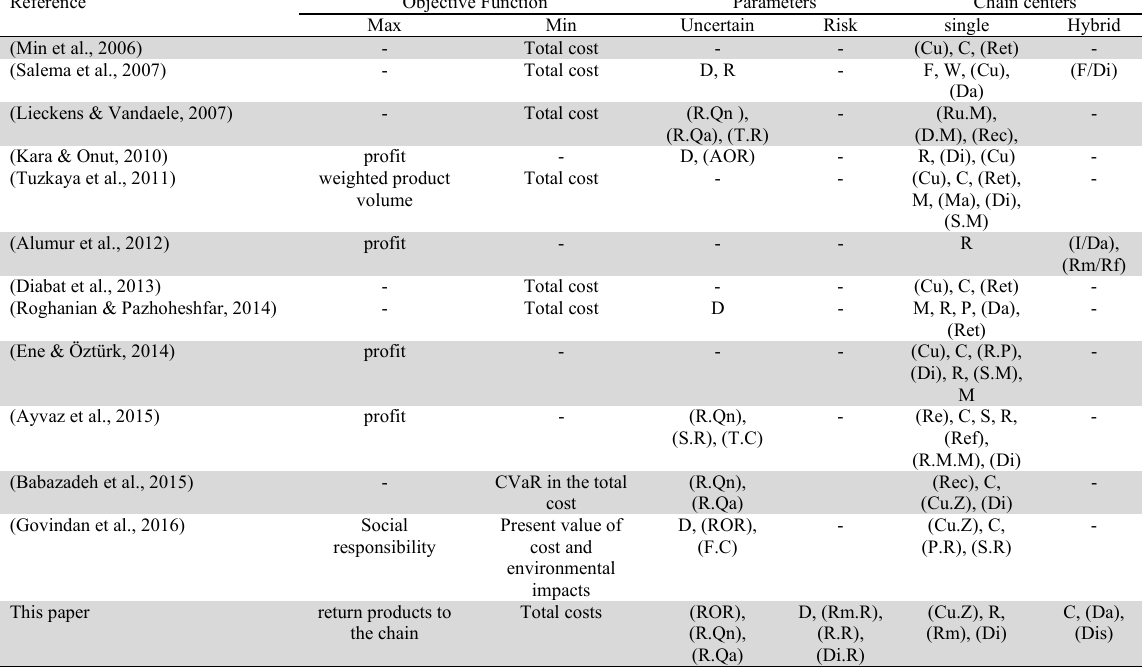
Modeling approach and network structure of the reviewed works